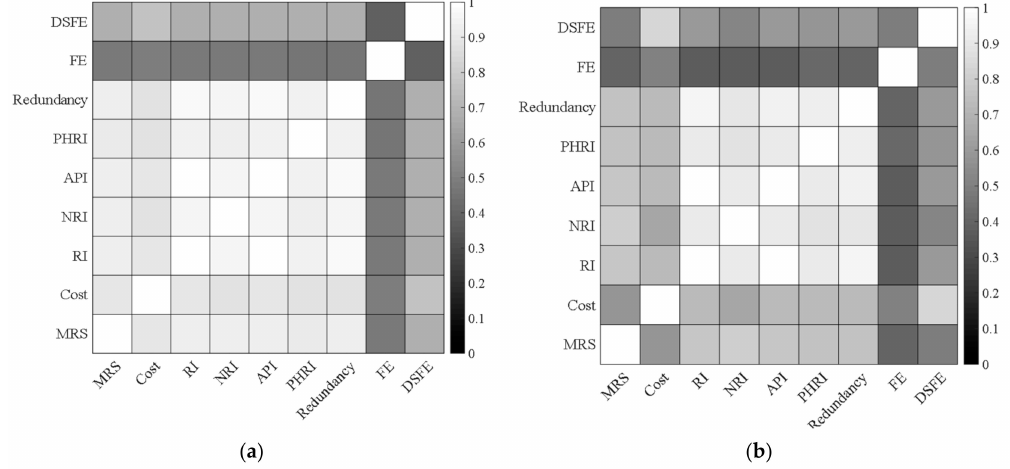
Figure 6. Consistency value of each pair of surrogate indicators. ( a ) HAN; ( b )